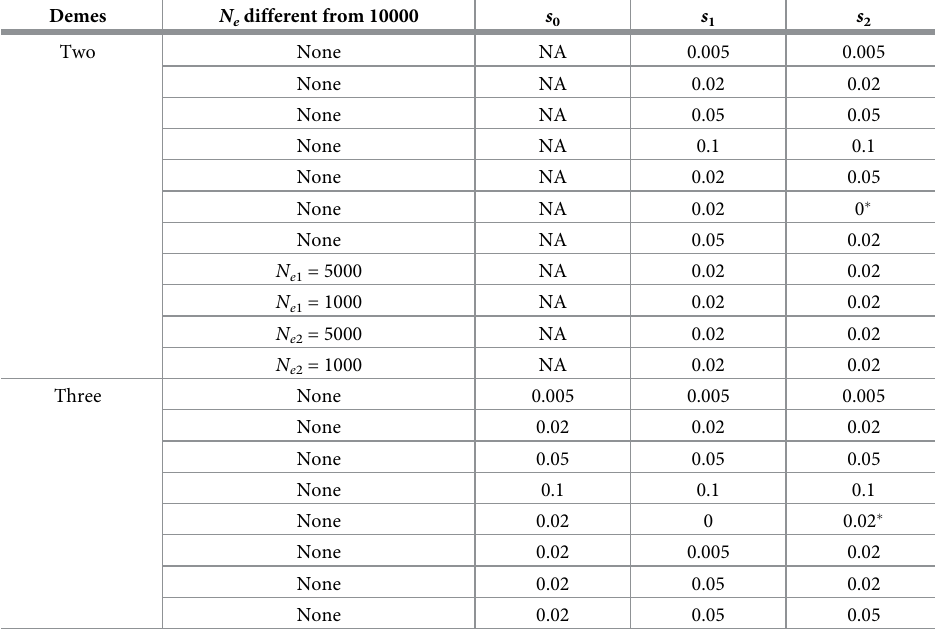
Table 1. Single-site: List of (haploid) population sizes and selective coefficients. Each row is a scenario that contains 1, 000 replicates for each migration rate. For the scenarios marked with an asterisk, the migration rate Nm = 0.02 was not used. s 0 , s 1 , and s 2 are the selection coefficients for demes d 0 , d 1 , and d 2 respectively. Demes N e different from 10000 s 0 s 1 s 2 Two None NA 0.005 0.005 None NA 0.02 0.02 None NA 0.05 0.05 None NA 0.1 0.1 None NA 0.02 0.05 None NA 0.02 0 � None NA 0.05 0.02 N e 1 = 5000 NA 0.02 0.02 N e 1 = 1000 NA 0.02 0.02 N e 2 = 5000 NA 0.02 0.02 N e 2 = 1000 NA 0.02 0.02 Three None 0.005 0.005 0.005 None 0.02 0.02 0.02 None 0.05 0.05 0.05 None 0.1 0.1 0.1 None 0.02 0 0.02 � None 0.02 0.005 0.02 None 0.02 0.05 0.02 None 0.02 0.05 0.05 All population sizes are 10,000 per deme if not specified